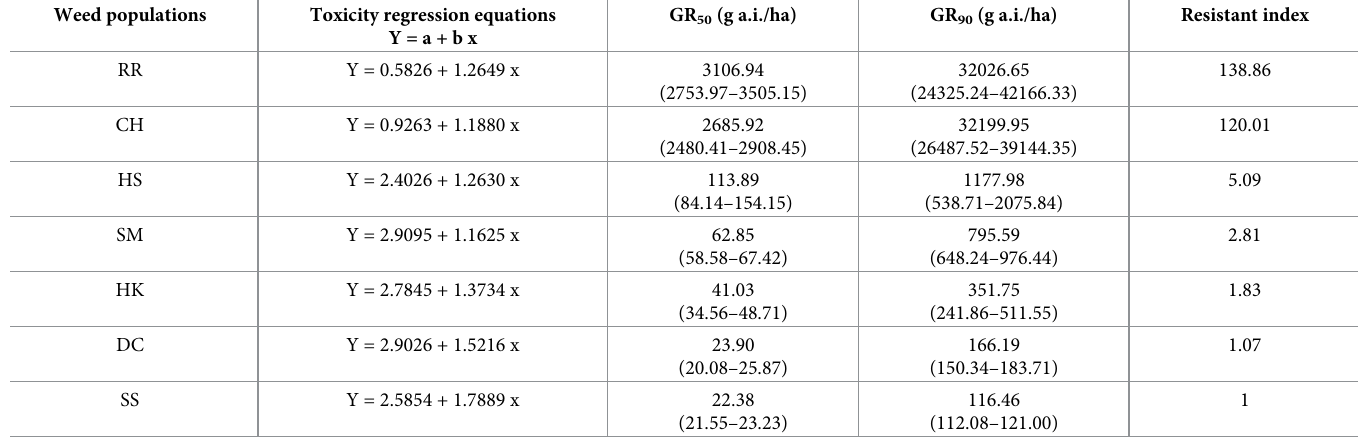
Table 1. Quinclorac dose–response analyses for E . crusgalli biotypes. Weed